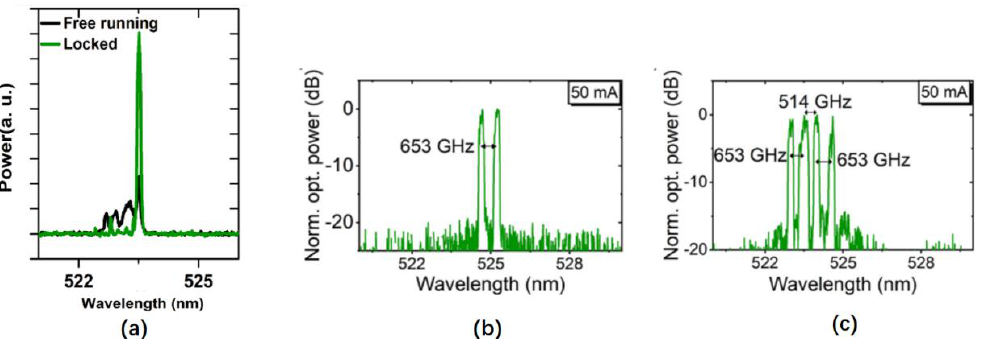
Figure 3. ( a ) The enhancement in the power of free-running (black) and self-injection-locked (green) systems for green LDs [18]; the normalized multiwavelength spectra of self-injection-locked external cavity systems with simultaneous ( b ) dual-and ( c ) four-mode generation, with an injection current (temperature) of 50 mA (40 °C) from a multiwavelength laser system [20].